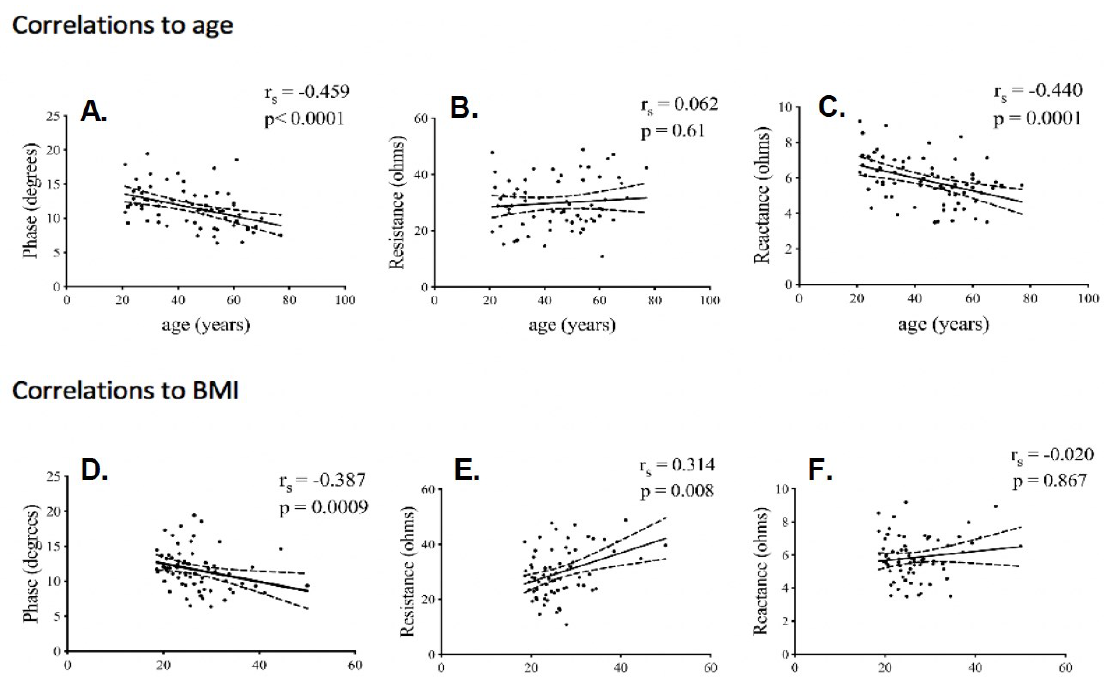
Figure 5. A, B, C. Correlation between phase, resistance, and reactance values at 100 kHz and age. Both phase and reactance show a significant relationship, whereas resistance does not. D, E, F. Correlation between phase, resistance, and reactance values at 100 kHz and age. Both phase and resistance show a significant relationship, whereas reactance does